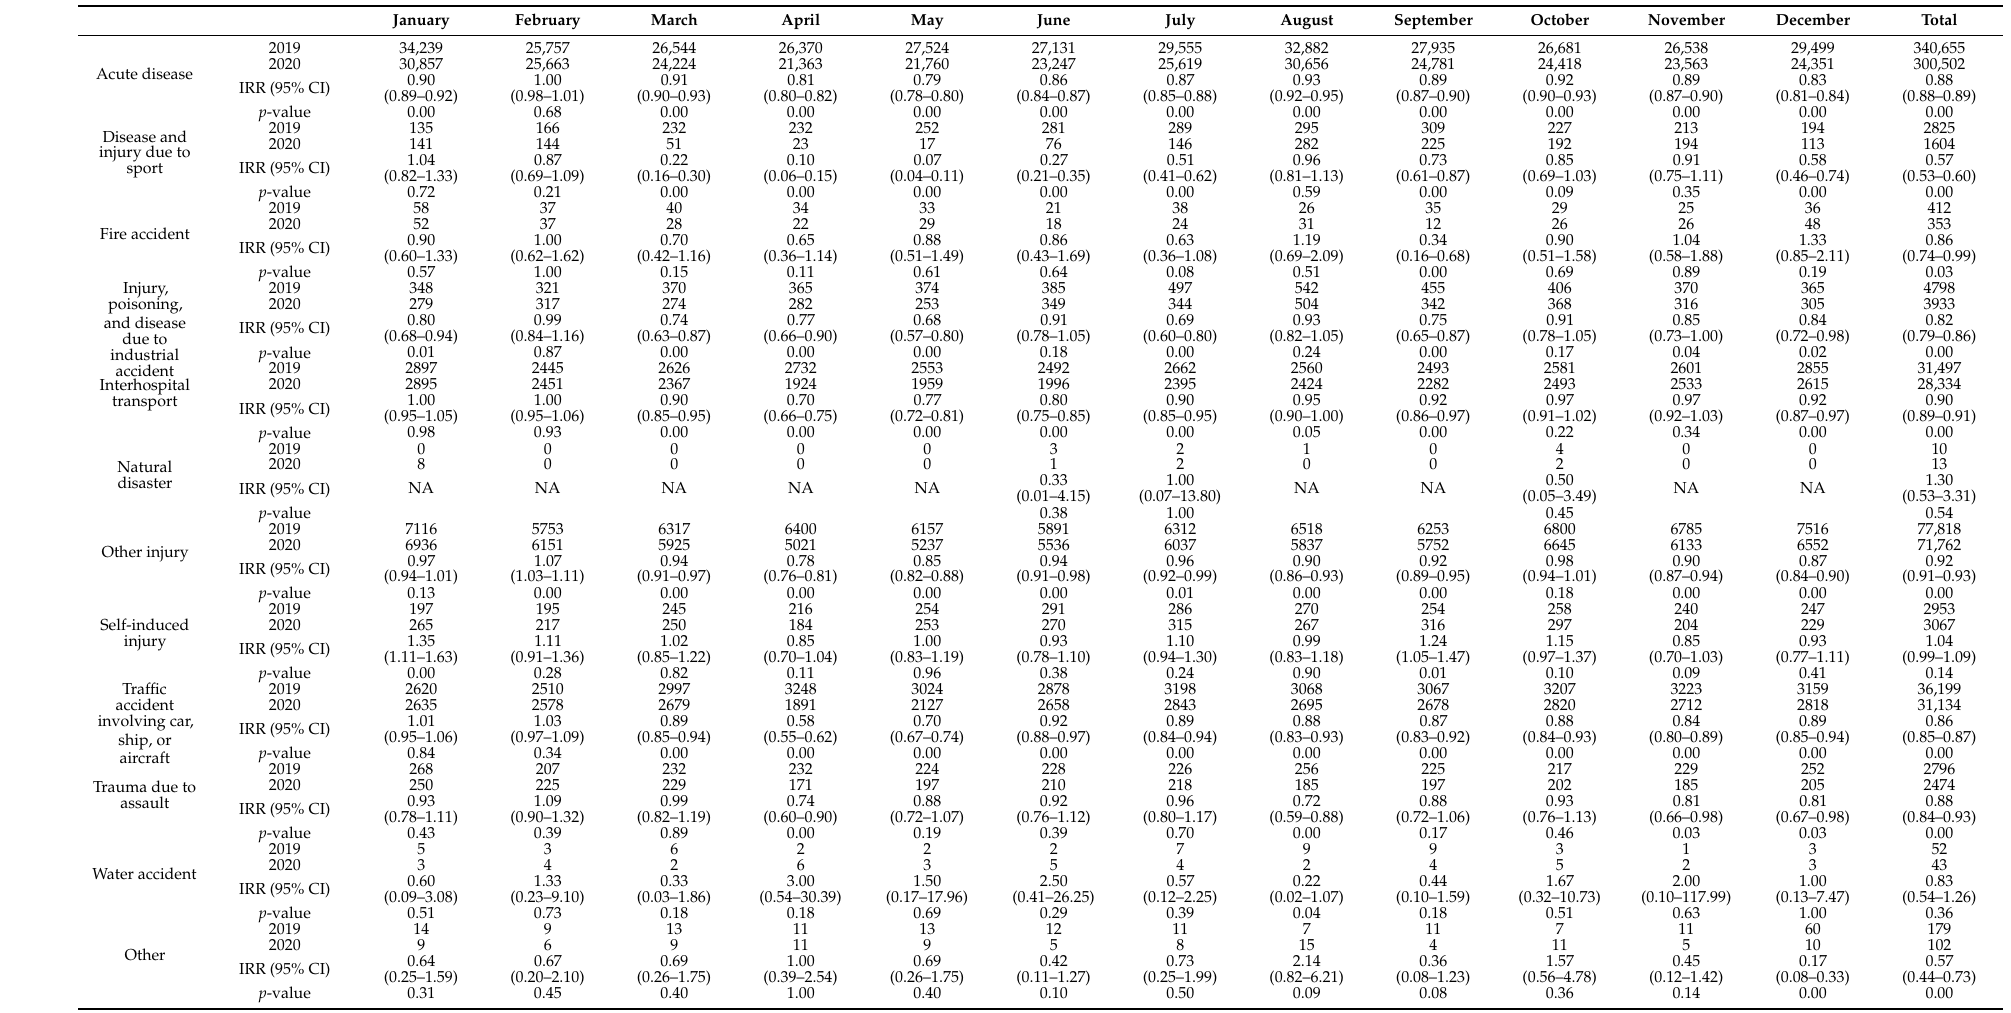
Table 1. The number of emergency patients registered in the Osaka Emergency Information Research Intelligent Operation Network